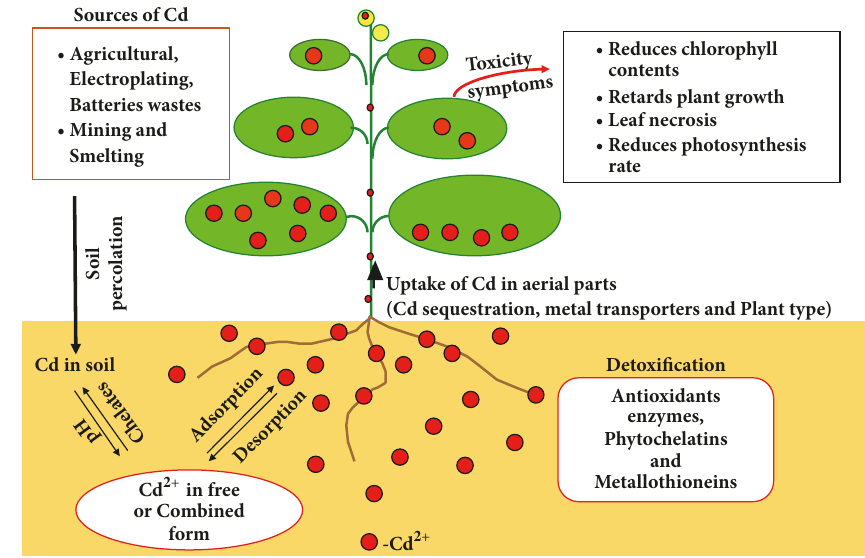
Figure 4: Phytoremediation mechanism of Cd adopted by soil